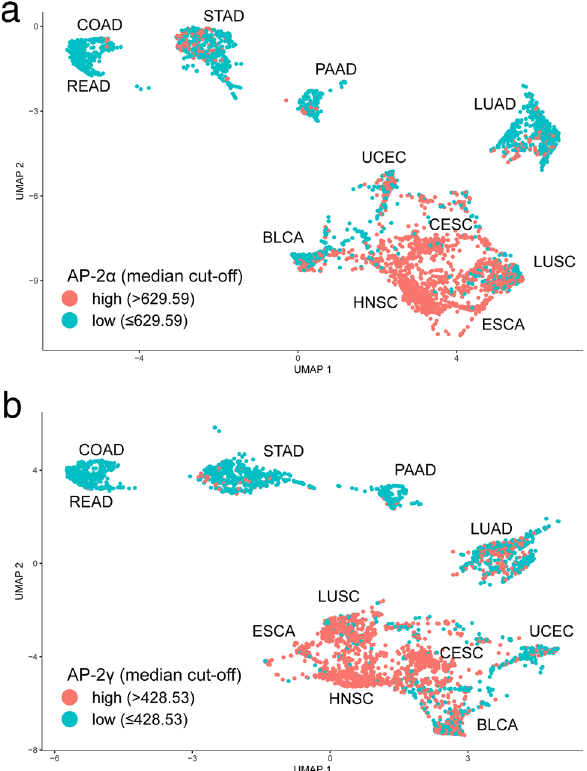
Figure 2. Spatial analysis showing differences between AP-2 factor level. ( a ) AP-2α. ( b ) AP-2γ. Figure created using Monocle3 (https:// cole- trapn ell- lab. github. io/ monoc le3/).